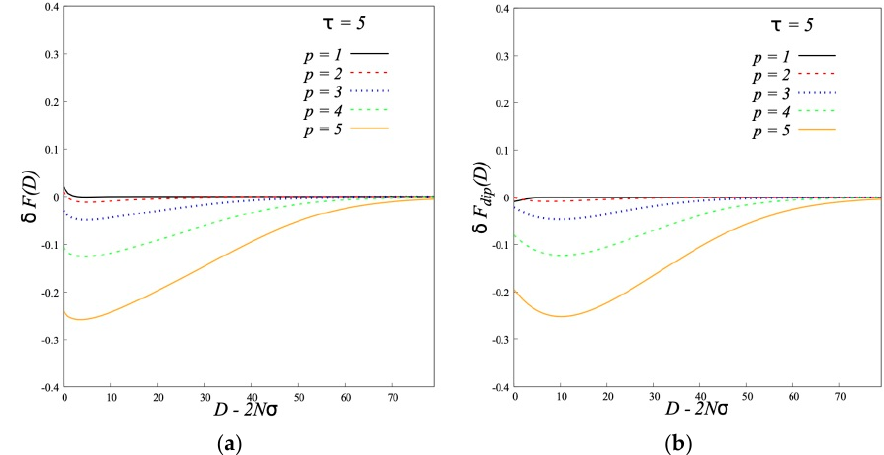
Figure 10. Interaction free energy δ F ( D ) of two dipolar brushes ( τ = 5) grafted to two parallel impenetrable surfaces ( a ). The dipole-dipole interactions δ F dip ( D ) ( b ). In all cases, the degree of polymerization of the grafted chains and solvent molecules is equal to N = 200, the grafting density is σ = 0.3.